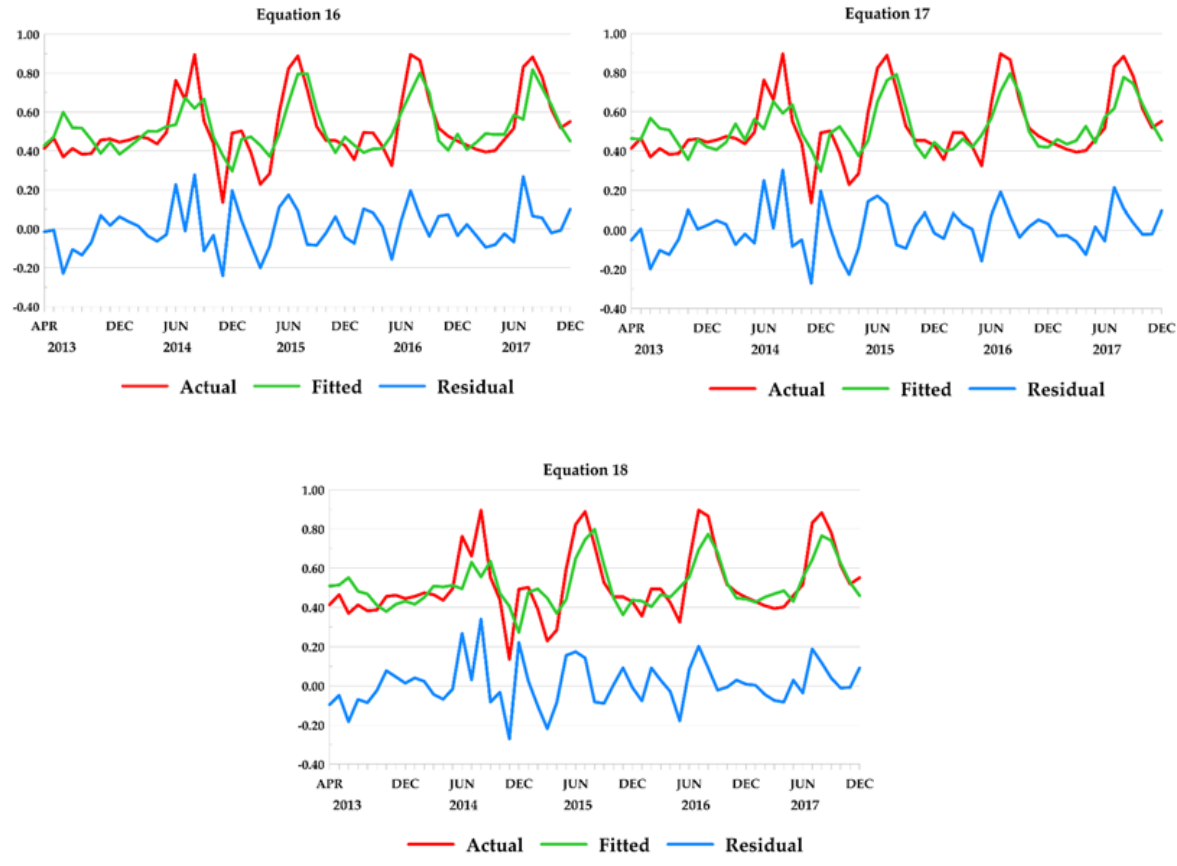
Figure 7. Representation for type 3 maize, estimation model and the residuals given by Equations (16)–(18). The last considered model taking into account the dynamic structure of the time series was